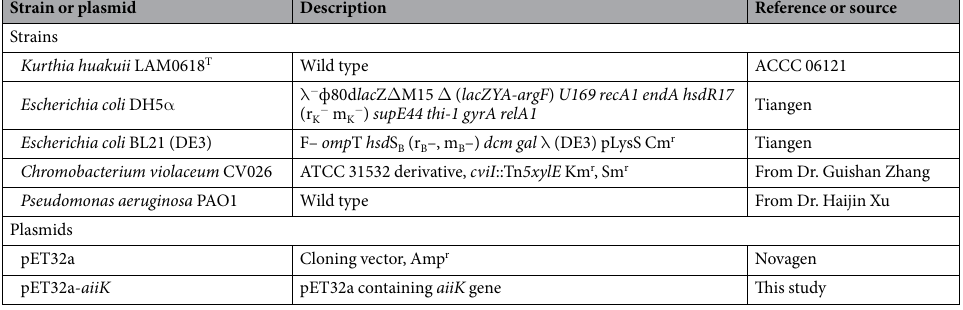
Table 3. Bacterial strains and